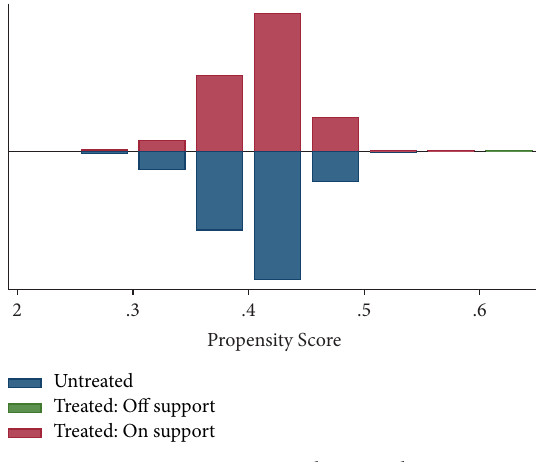
Figure 1: PSM matching results. Table 4: Heterogeneity of patent natures and enterprise natures.